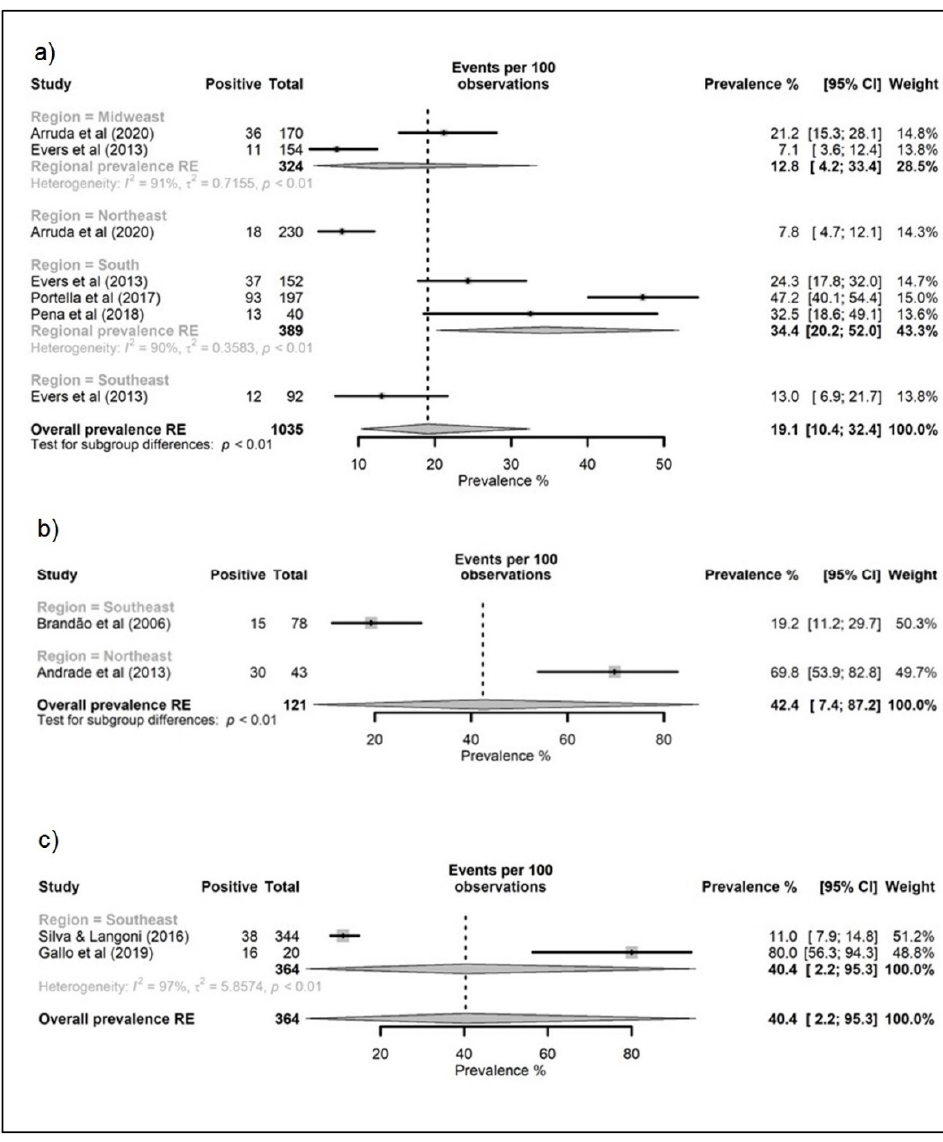
Figure 5. Forest tree of studies reporting toxoplasmosis prevalence in equids and avian slaughtered for human consumption in Brazil, grouped by administrative region. ( a ) Equids, ( b ) chickens, and ( c ) ostriches. CI: confidence interval; RE: random